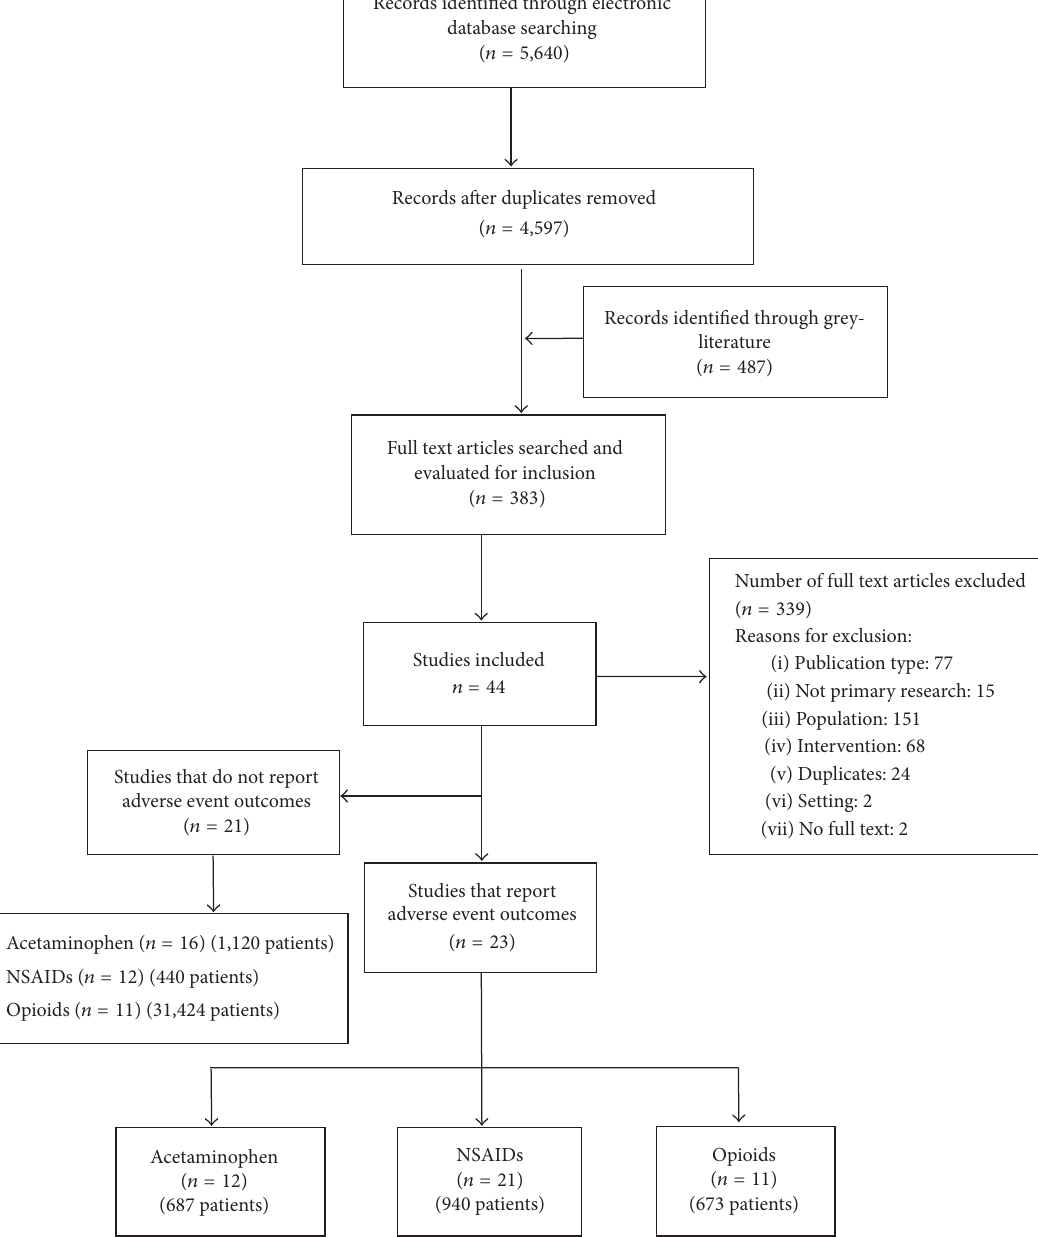
Figure 1: PRISMA flow diagram of study retrieval and